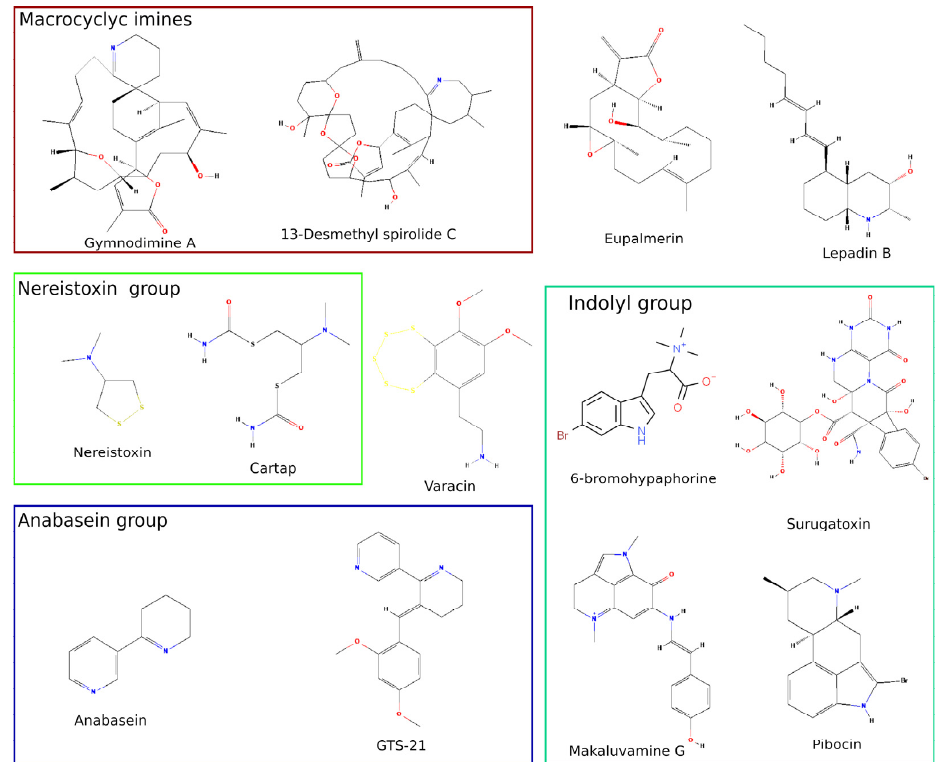
Figure 1. Diversity of low-molecular weight nicotinic acetylcholine receptor (nAChR) ligands of marine origin and some of their synthetic analogs. Nitrogen atoms are indicated in blue, oxygen in red, sulfur atoms in yellow and bromine in brown.